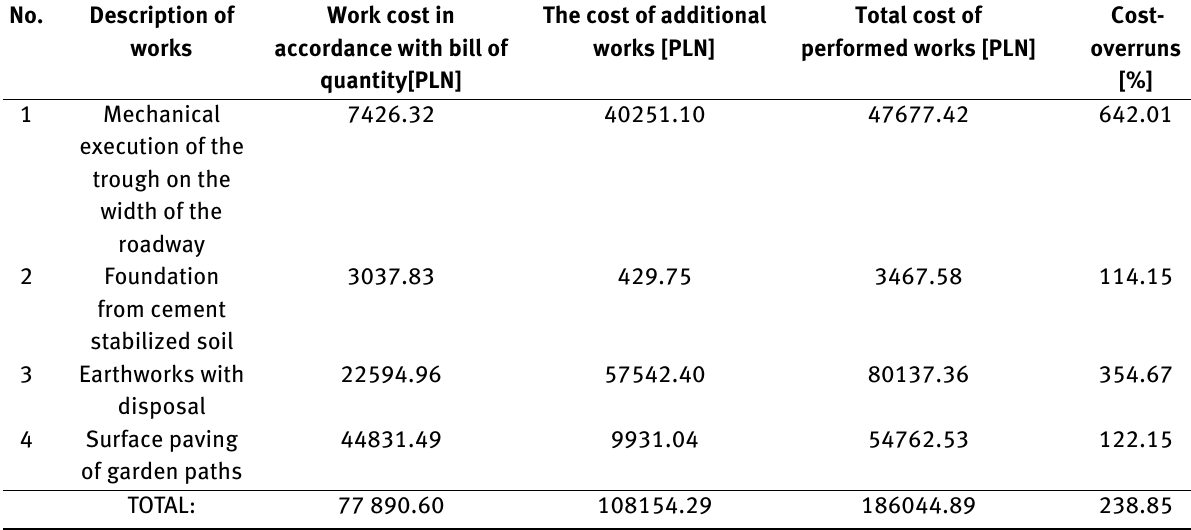
Table 4: Cost list of selected renovation works from a bill of quantities and a quantity survey for comparison facility No. 1 - renovation of external communication routes of the historic building